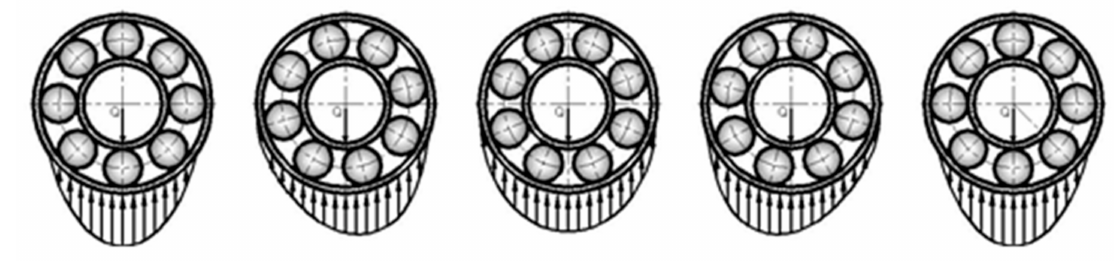
Figure 2. Periodic change of load distribution inside the rolling